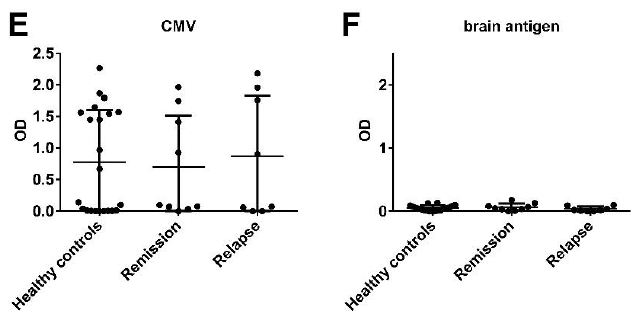
Figure 2. No significant difference in the virus-, but in the brain-specific B cell activity between healthy controls and MS patients. PBMC and plasma were obtained from healthy controls, MS patients experiencing an acute relapse and MS patients in remission. The numbers of Epstein-Barr virus (EBV)- ( A ); Cytomegalovirus (CMV)- ( B ) and brain antigen-specific ( C ) B cells in the polyclonally stimulated PBMC population are shown in addition to the plasma antibody level for EBV ( D ); CMV ( E ) and brain antigen ( F ) for each individual donor in the specified groups. Bars represent median values and standard deviations.